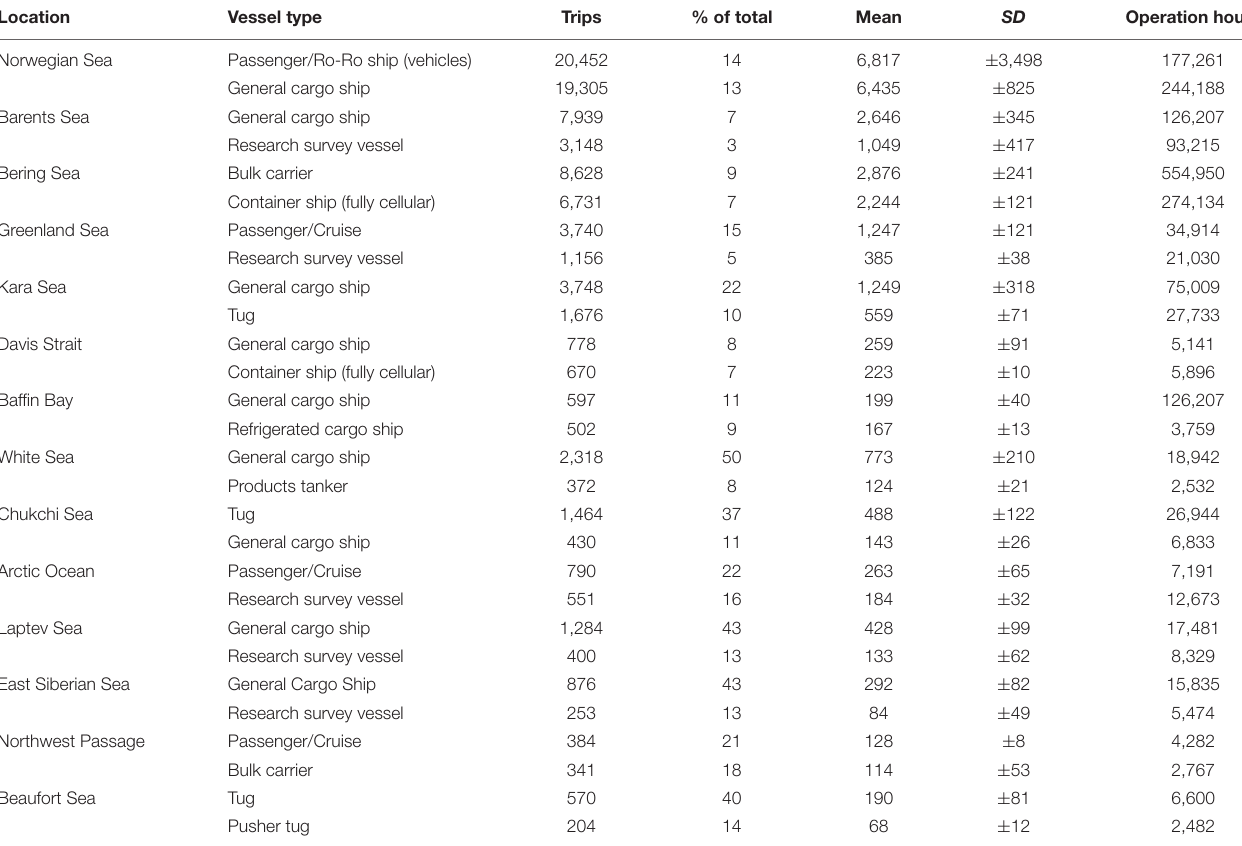
TABLE 5 | Two most common (as measured by number of trips) vessel classes in each Arctic waterway studied. Location Vessel